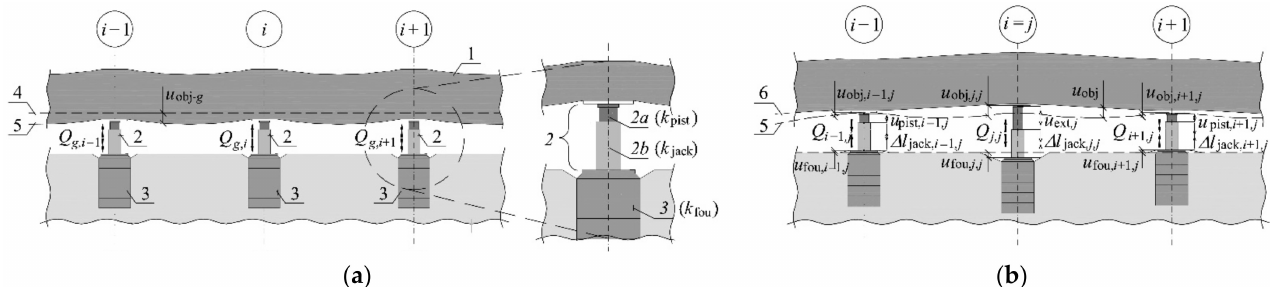
Figure 3. Displacements of the structure components, piston extensions and changes in forces in the jacks: ( a ) tank resting on the jacks prior to lifting; ( b ) tank after forced piston extension in the active j -th jack of value u ext, j : 1—elevated tank, 2—jack (2a—piston characterized by stiffness k pist , 2b—cylinder characterized by stiffness k jack ), 3—jack support characterized by stiffness k fou , 4—position of the tank before installing the jacks, 5—position of the tank when jacks took the tank weight, 6—position of the elevated tank after the forced piston extension by the value u ext, j